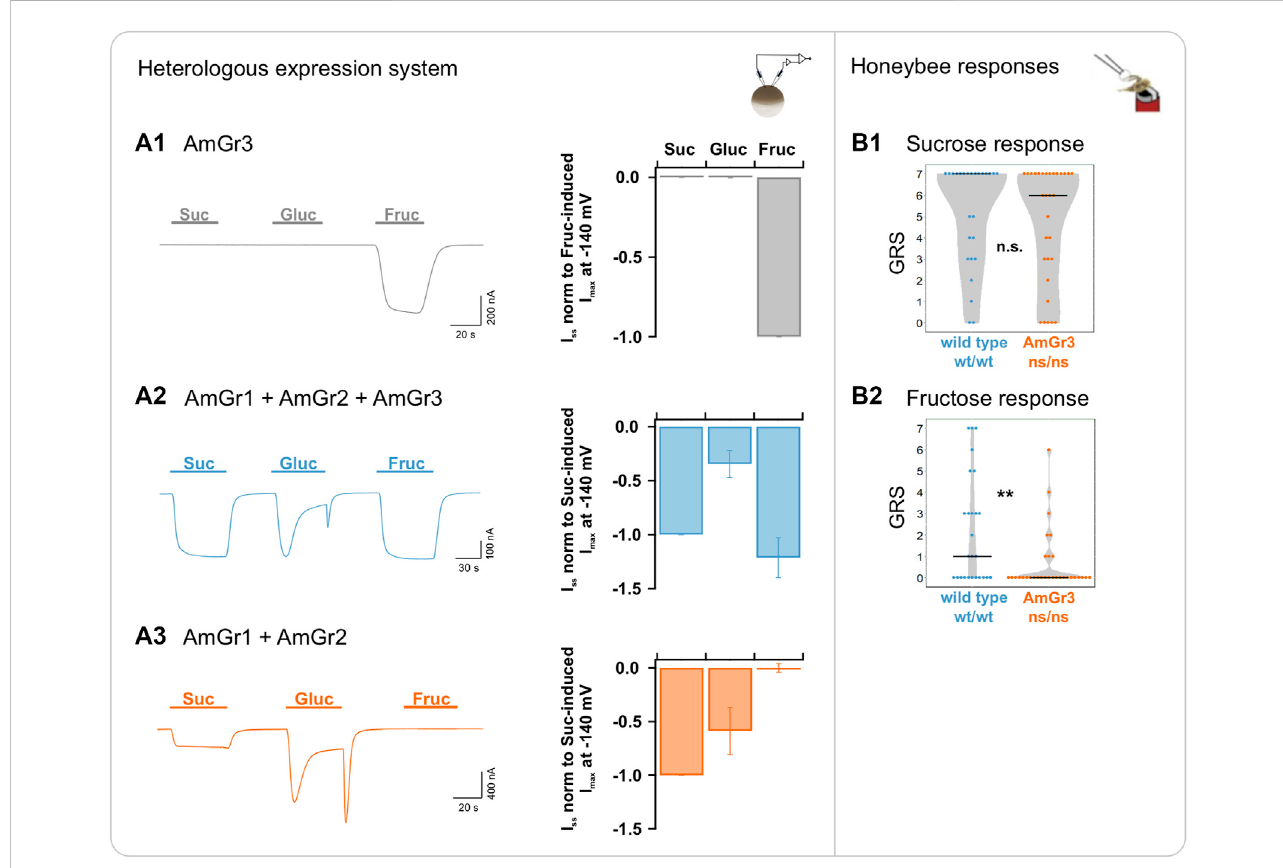
FIGURE 3 Functional analysis of A. mellifera gustatory receptor AmGr3 using a matched heterologous expression system and in vivo comparative approach. (A1 – A3) : two-electrode voltage clamp measurements: Current traces were recorded at a holding potential of − 80 mV in response to perfusion with sucrose (Suc), glucose (Gluc) and fructose (Fruc) in standard solution (left panels). Sugar-induced I SS were recorded at a membrane potential of − 140 mV (middle panels). (A1) Representative whole oocyte current trace of AmGr3-expressing oocyte (left panel); Currents are normalized to the fructose-evoked I SS at − 140 mV (mean of n = 8 oocytes ± SD; middle panel). (A2) Control (for clari fi cation displayed again): Inward whole oocyte currents from AmGr1/AmGr2/ AmGr3-expressingoocyte(wild-typemimicry,leftpanel);currentswerenormalizedtosucrose-induced I SS at − 140 mV(meanof n =10oocytes±SD;middle panel).Thesesamevaluesaredisplayedinall fi guresasconsistentcontrol. (A3) WholeoocytecurrentsfromAmGr1/AmGr2co-expressingoocyte(,leftpanel); currents were normalized to sucrose-induced I SS at − 140 mV (mean of n = 13 oocytes ± SD; middle panel). (B1 – B2) (as published previously in Degirmenci et al., 2020): behavioural evaluation through proboscis extension response (PER, in vivo ). Wild-type (wt/wt, N = 26) and AmGr3 mutant bees (ns/ns; N = 31) were presented a series of sugar concentrations (16%, 20%, 25%, 32%, 40%, 50% and 63% ( w/v ); representing .47 M, .58 M, .73 M, .93 M, 1.17 M, 1.46 M and 1.84 M) of the sugars sucrose (B1) and fructose (B2) . The sum of the responses (PERs) towards one of the sugars was recorded as a sugar-speci fi c GRS (gustatory response score). The distribution of all GRS values of all measured bees is shown as data points and the resulting medians as lines. AmGr3 mutants did not show any difference in GRS when compared with wild-type bees (B1) ; Mann-Whitney-U, ns/ns vs. wt/wt, p = .4279, n.s.). Fructose GRS of AmGr3 mutants were signi fi cantly lower than those of wild-types (B2) ; Mann-Whitney-U, ns/ns vs. wt/wt, p = .0062, **). Because of experimental limitations (such as short survival of the AmGr3 mutants), glucose measurements were not implemented and cannot be pursued